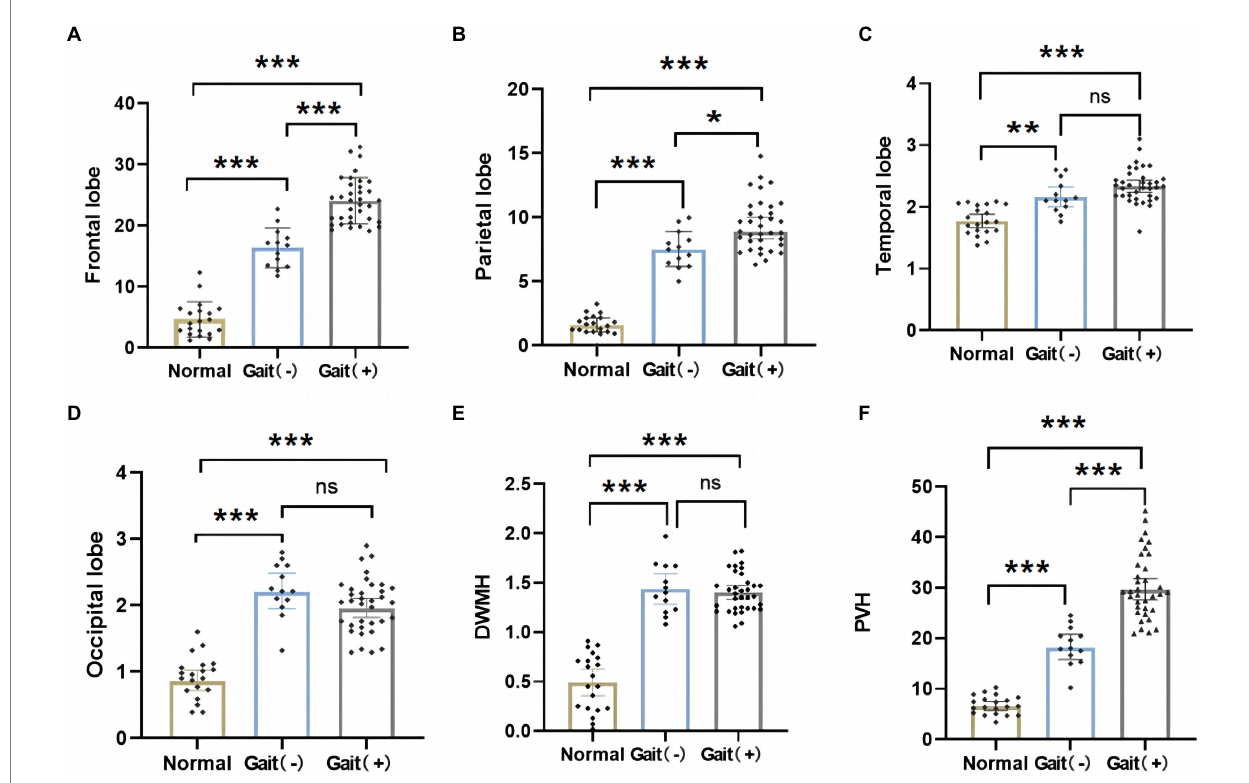
FIGURE 4 Differences in regional WMH among normal olders, gait (+) group and gait ( − ) group. (A,B,F) WMH in the frontal and parietal lobes, PVH of the gait (+) group were higher than those in the gait ( − ) group and the normal olders. (C–E) WMH in temporal and occipital lobes, DWMH were higher in the gait (+) group than the normal olders. And there was no statistical difference between the gait (+) group and gait ( − ) group. *** p < 0.001, ** p < 0.01, and * p < 0.05. PVH, periventricular white matter hyperintensity; DWMH, deep white matter